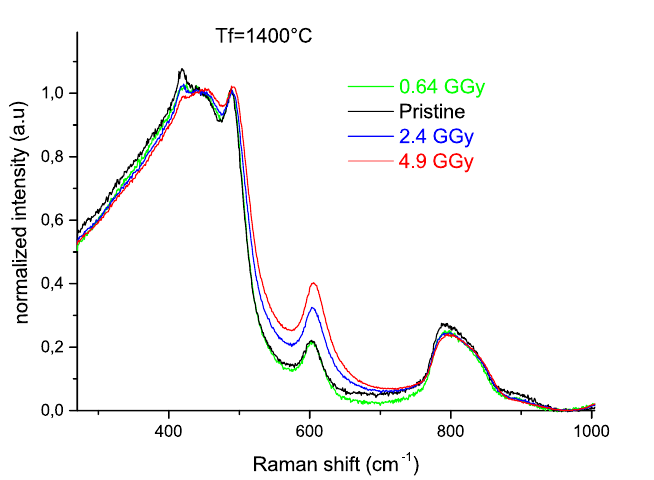
Figure 4. Raman spectra evolution with the integrated dose of (T f = 1250 °C) samples.